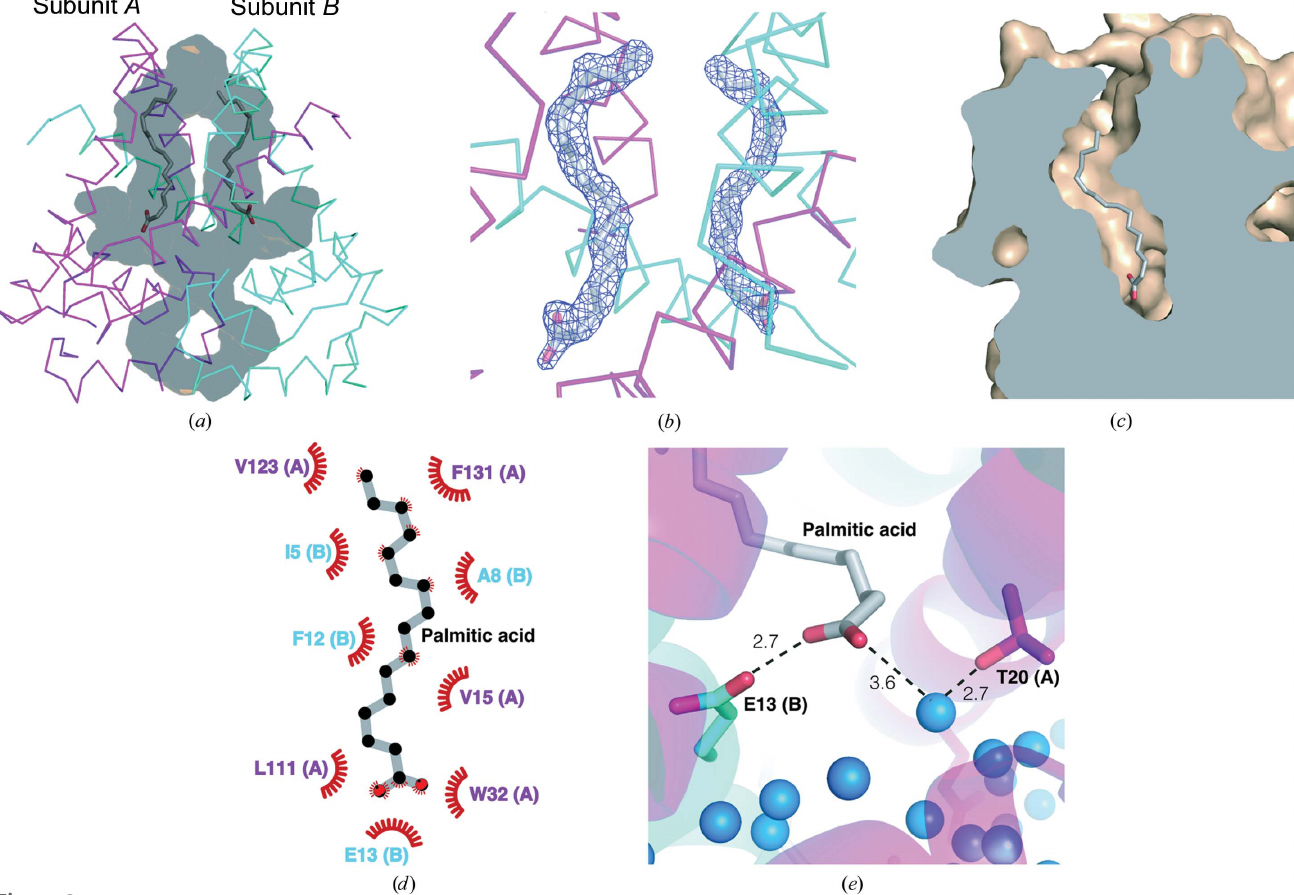
Figure 2 Putative effector-binding site of Pa MarR. ( a ) Cavities of Pa MarR. Translucent grey lumps indicate cavities, including the putative effector-binding sites. Palmitic acid molecules are represented as sticks. ( b ) OMIT map of palmitic acid. The OMIT map ( F o (cid:3) F c ) is coloured blue and contoured at the 3.0 (cid:5) level. ( c ) A cross-section representing a cavity including the putative effector-binding site. Palmitic acid is represented as sticks. ( d ) Diagram of palmitic acid interactions with adjacent hydrophobic residues. Black and red circles indicate C and O atoms, respectively. ( e ) Interactions between palmitic acid and adjacent hydrophilic residues. Blue spheres and black dashed lines indicate water molecules and hydrogen bonds,